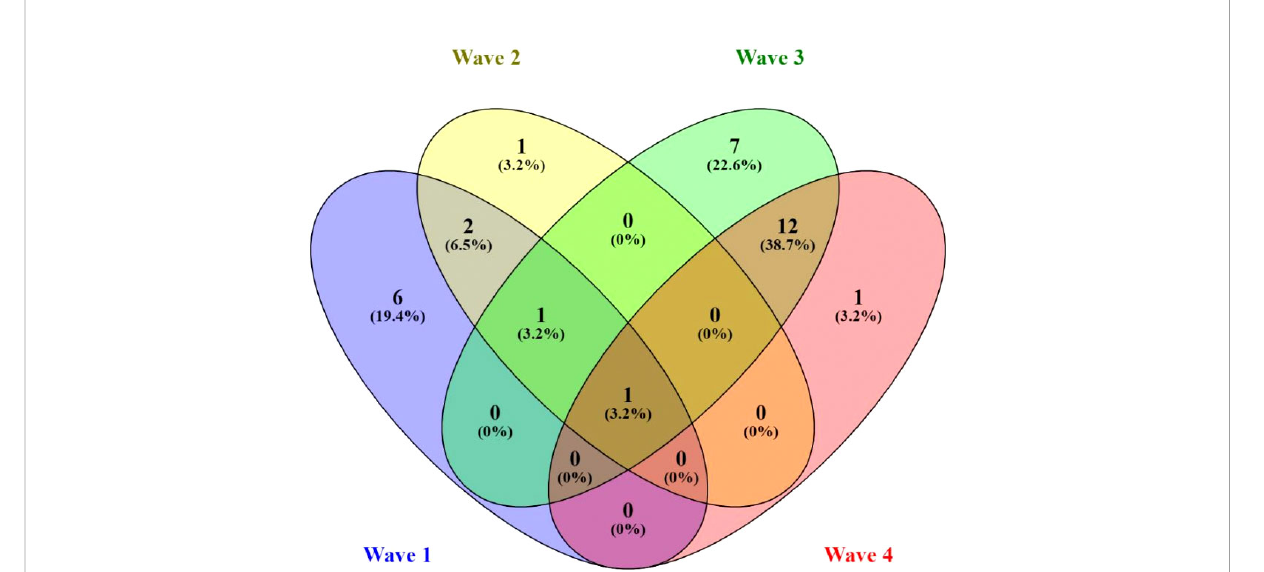
FIGURE 3 Venn diagram indicating the unique and the overlapping SARS-CoV-2 variants in each epidemic wave. In each wave, the number of unique and overlapping genome variants identi fi ed during the analysis of each peak infections are indicated in absolute numbers and percentages. The fi rst, second, third and fourth waves are denoted by blue, yellow, green and red colours,